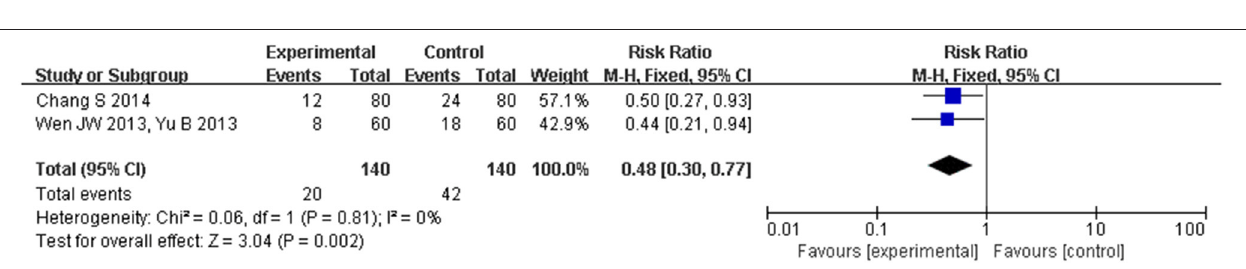
FIGURE 7 | Forest plot of the comparison between CHM and control for all-cause mortality in 6 months after discharge.